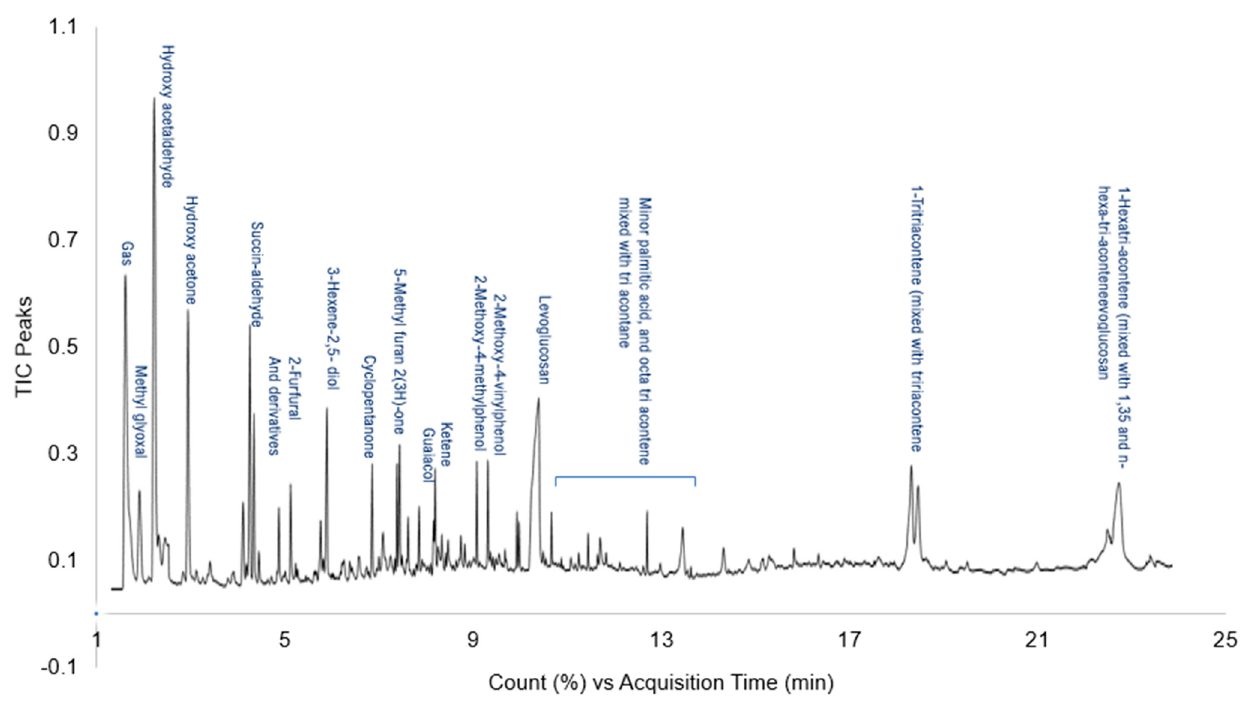
Figure 5. Major pyrolites from HC of TPB. Table 4. List of pyrolite compounds from Py-GC-MS analysis of HC produced at 220°C.